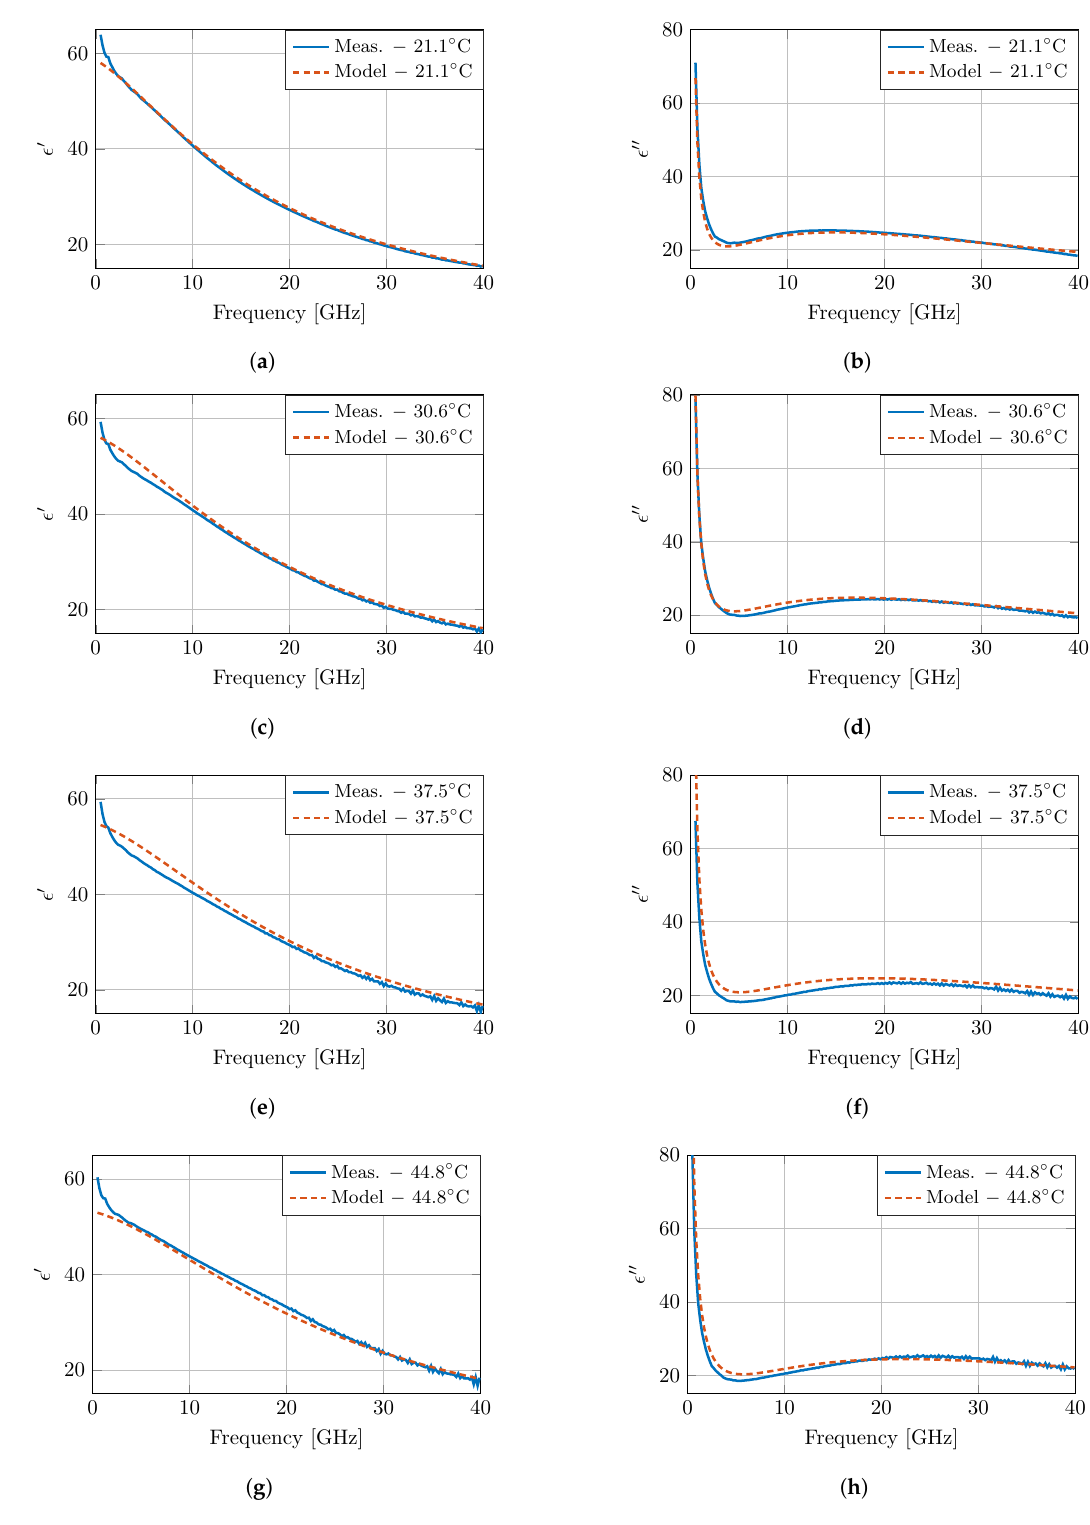
Figure 7. The dielectric properties of muscle tissue as proposed by the presented model and compared to the measurements at four temperatures as presented in Figure 5. The real and imaginary part are displayed in ( a ), ( c ), ( e ), ( g ) and ( b ), ( d ), ( f ), ( h ),